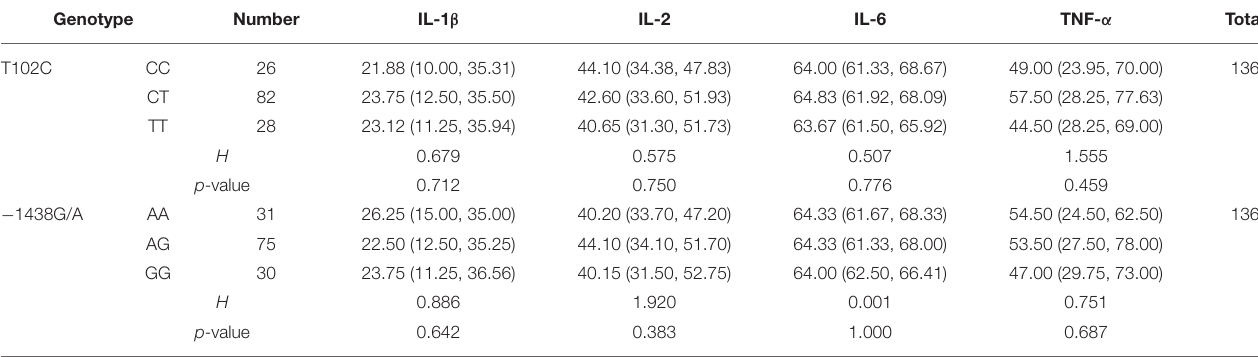
TABLE 7 | Distribution of T102C and − 1438G/A genotypes across different sleep quality groups. Genotype